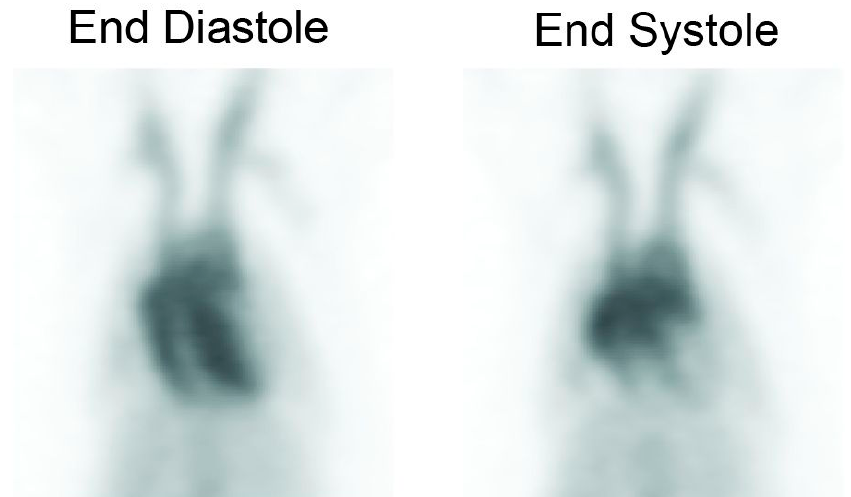
Figure 4. Gated blood pool images of a rat, rebinned using 8 gates per frame. The left image is from gate 8 (end diastole), while the right image shows gate 3 (end systole).